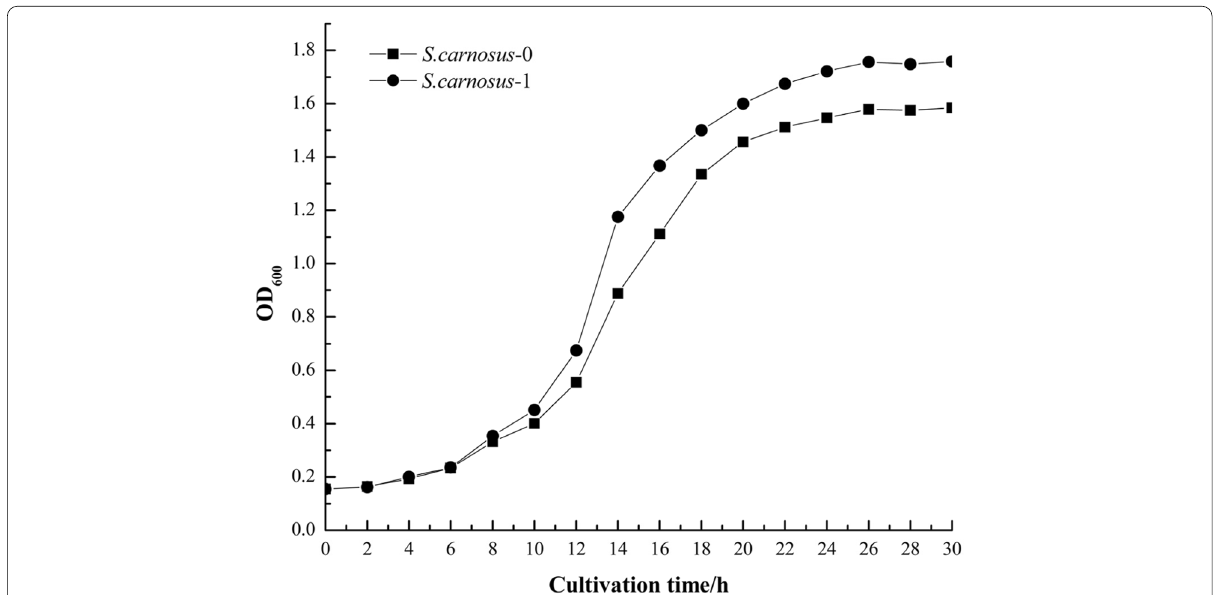
Fig. 2 Growth curves for S. carnosus -0 and S. carnosus -1